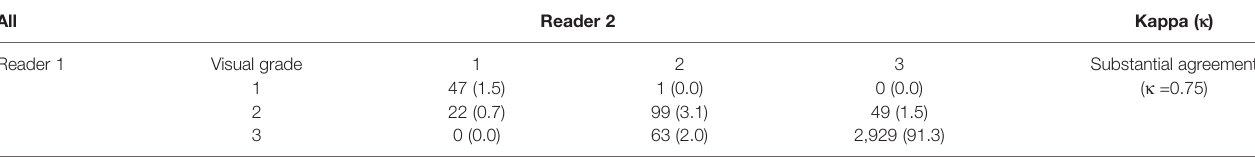
TABLE 4 | Confusion matrices between the visual grades assigned by two